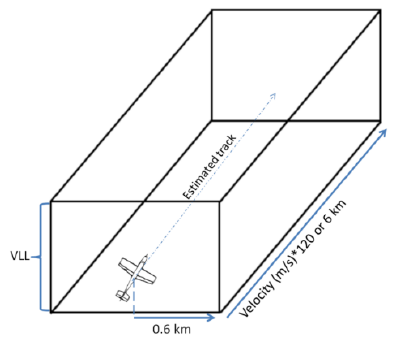
Figure 14. Dynamic geofence considered around the manned aircraft in VLL.